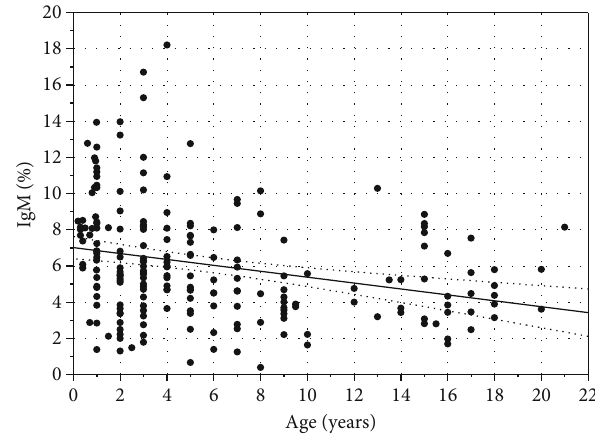
Figure 4: Relationship between relative concentration of IgM in serum and age of European bison. Dotted lines represent 95% con fi dence intervals ( R Spearman = 0 : 361 , p < 0 : 0001